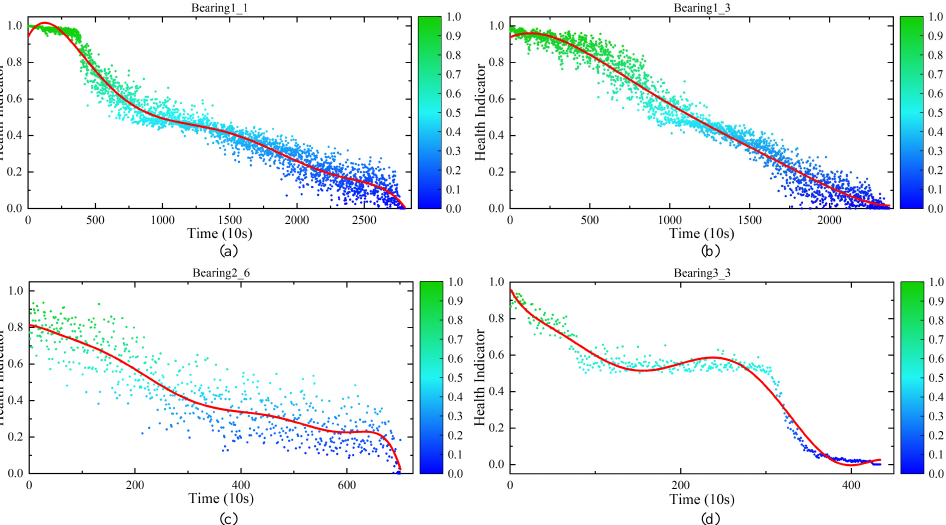
Figure 9. The HI of four testing bearings. ( a ) The HI of Bearing1_1. ( b ) The HI of Bearing1_3. ( c ) The HI of Bearing2_6. ( d ) The HI of